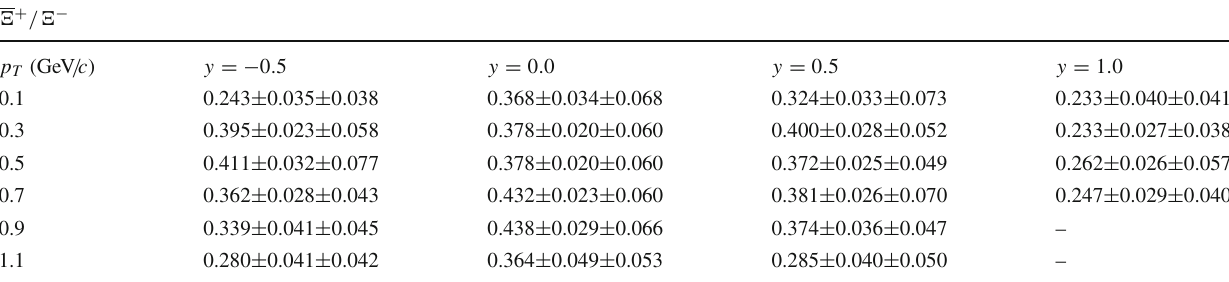
Table 5 The (cid:2) + /(cid:2) − ratio in inelastic p+p interactions at 158 GeV / c beam momentum. Rapidity and transverse momentum values corre- spond to the middle of the presented bin. First value is the particle ratio, (cid:2) + /(cid:2)